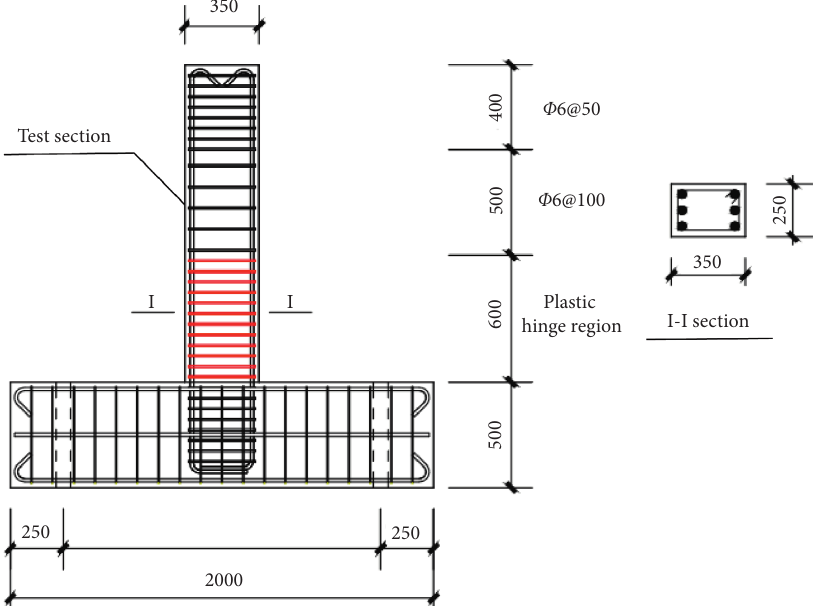
Figure 1: Test specimen (dimensions in